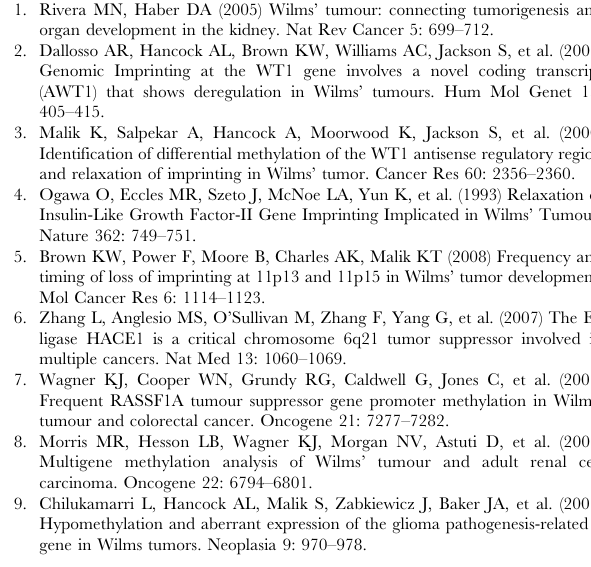
Figure S7 Suppression of colony formation is not dependent on non-specific toxicity of transfected genes. Mutant b -catenin (Y33, tyrosine at amino-acid 33) expression does not suppress colony formation in HEK293 cells. HEK293 cells were transfected with CTNNB1 cDNA cloned in the same expression vector (pcDNA3.1/Zeo) as PCDH constructs. After selection and staining, plates were photographed and colony counts determined for each transfection. Representative plates (above) and mean colony counts (below) are shown. Verification of b -catenin protein expression after transfection is shown by immunoblotting below the histograms, together with tubulin to control loading. Figure S8 Kidneys of heterozygous Pcdhg@ mutant mice show no malformations (see Text S1). Histology of three-month old wild-type (wt, n= 2) and heterozygous Pcdhg@ mutant kidneys (het, n = 3) was examined on cryosections. Staining of adjacent sections with cresyl-violet (left column) and nuclear fast red (middle and right columns) was used to highlight the cytoarchitecture of the specimens. The overall morphology of the heterozygous kidneys appeared normal and showed no malformations. Scale bars = 500 m m. At higher magnifications, findings were compa- rable in three-month old wild-type and heterozygous littermates and displayed normal cytoarchitecture in aged heterozygous mice (boxed areas are shown in the right column, scale bars = 100 m m). Table S1 Wilms’ tumour hypermethylated genes identified by MeDIP-chip. Summary table of hypermethylated genes identified by MeDIP-chip in five Wilms’ tumours ( P , 0.05). Ensembl gene ID, gene symbol, and co-ordinates by chromosome and gene start (HG18 genome build) are given. The frequency of hypermethyla- tion is given in the final column. Blanks in the Gene name column represent Refseq unannotated genes.